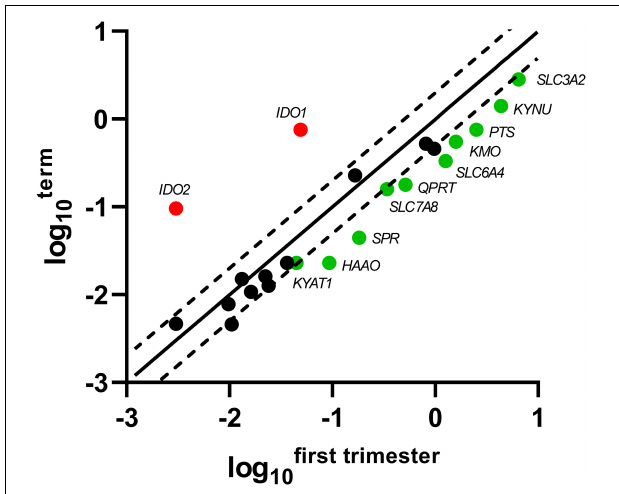
FIGURE 2 | Scatter plot of the TRP pathway enzymes/transporters showing significant changes in gene expression during gestation. Log 10 of each gene-specific 2 (cid:49) Ct in the first-trimester placenta is plotted against those of term placenta. The central diagonal line shows unchanged gene expression, whereas the dotted lines depict the upper and lower limit of the threshold fold regulation, which was set to 2. Data were further evaluated using non-parametric Mann–Whitney test on (cid:49) Ct values, and those that exceed the threshold fold regulation and were statistically significant ( p ≤ 0.05) are named and shown in color: red – up-regulation, green –